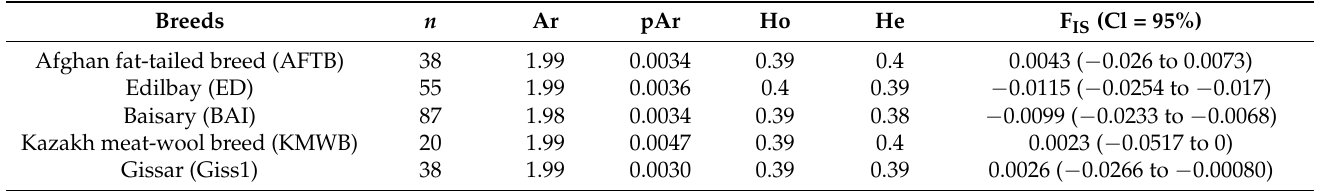
Table 3. Indices of genetic diversity of five sheep populations.